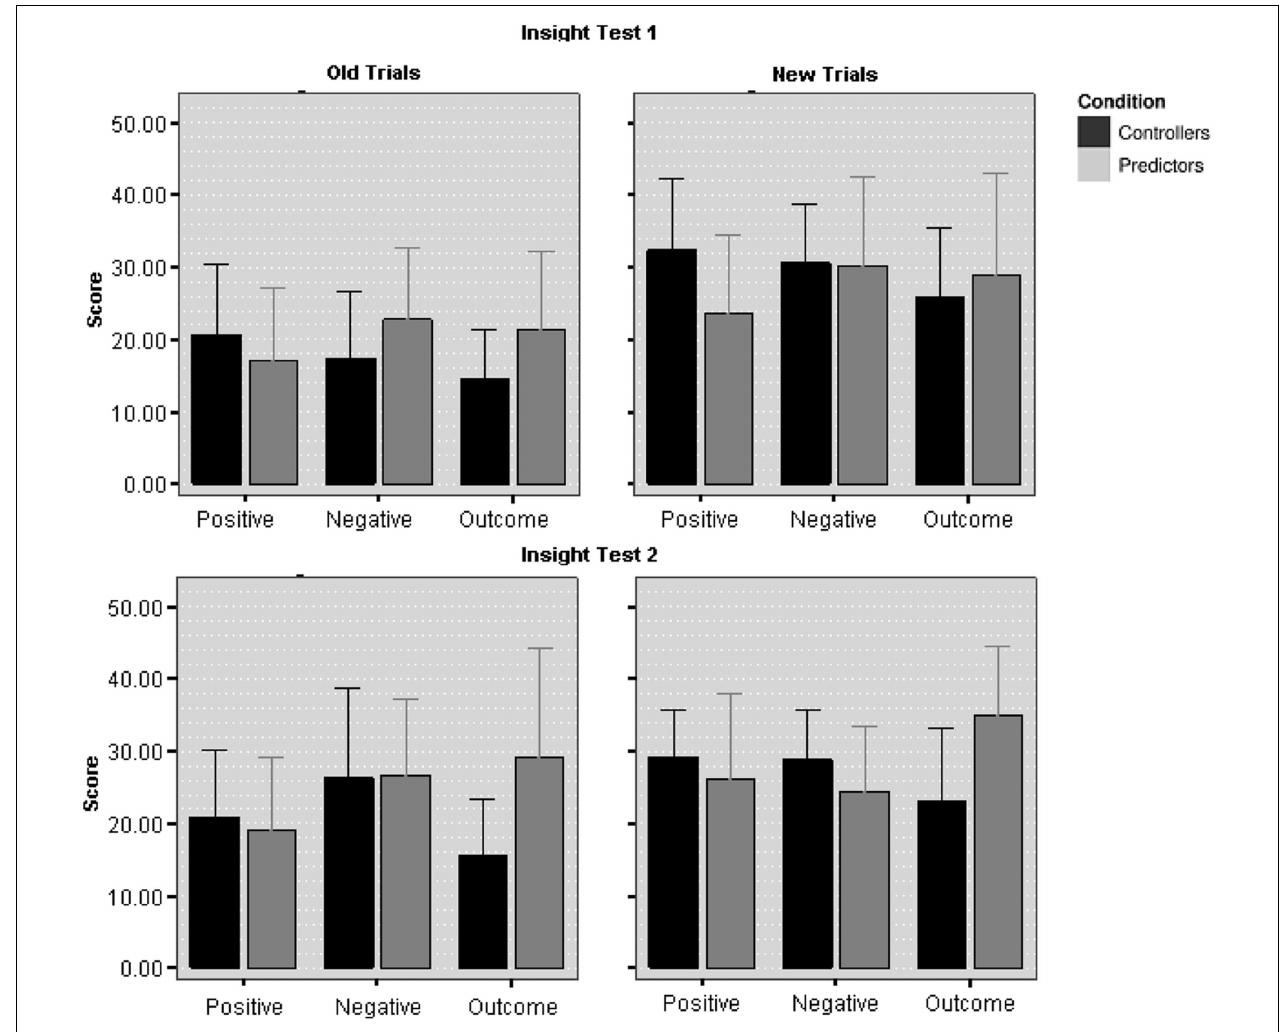
FIGURE 6 | Insight scores ( ± SE) for predictors and controllers for the insight tests of Experiment